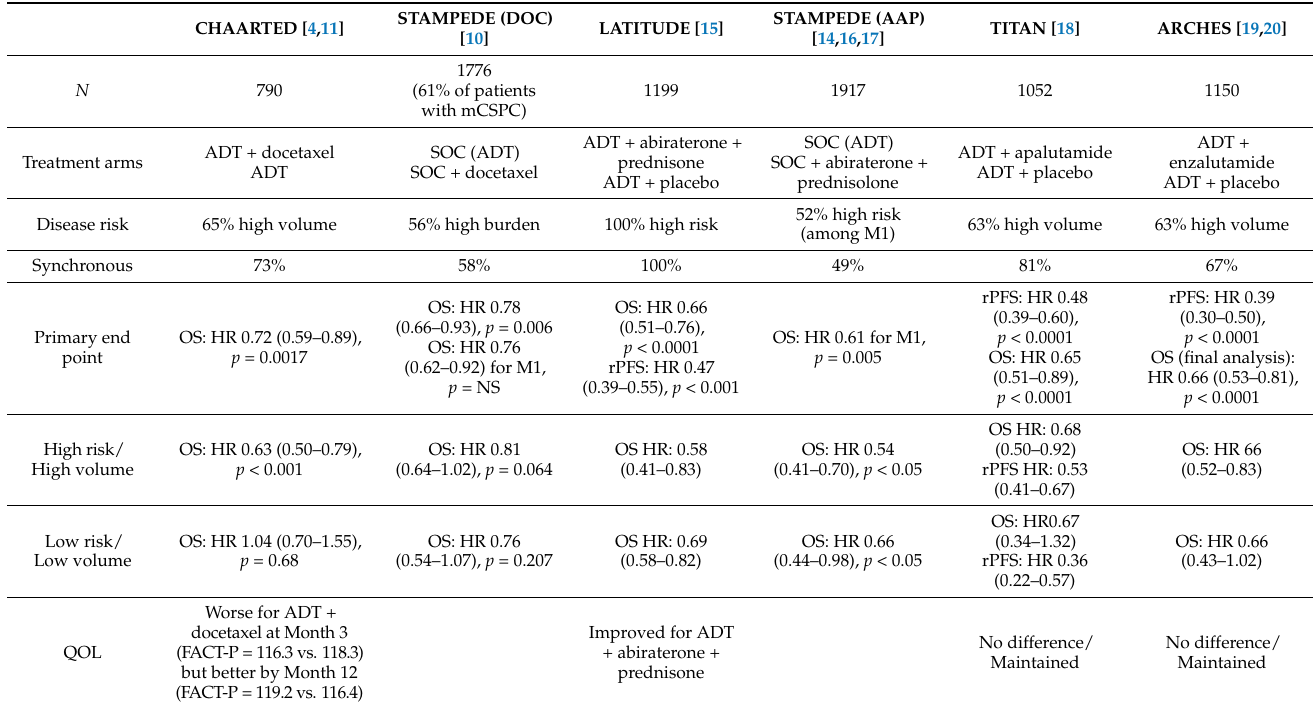
Table 1. Summary of trials evaluating doublet therapy in